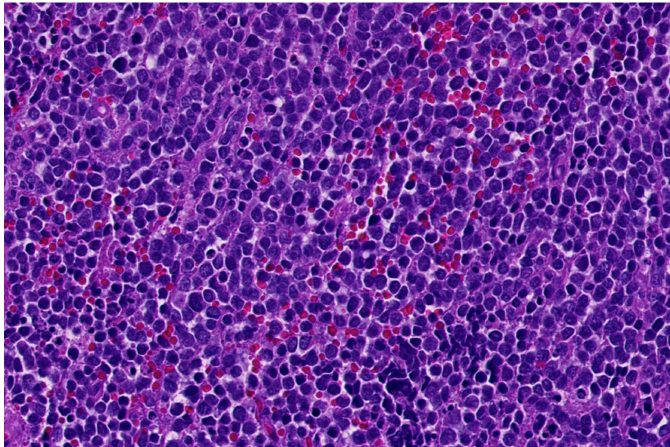
Figure 1. Classical morphology of Ewing sarcoma (HE; 40 × magnification).